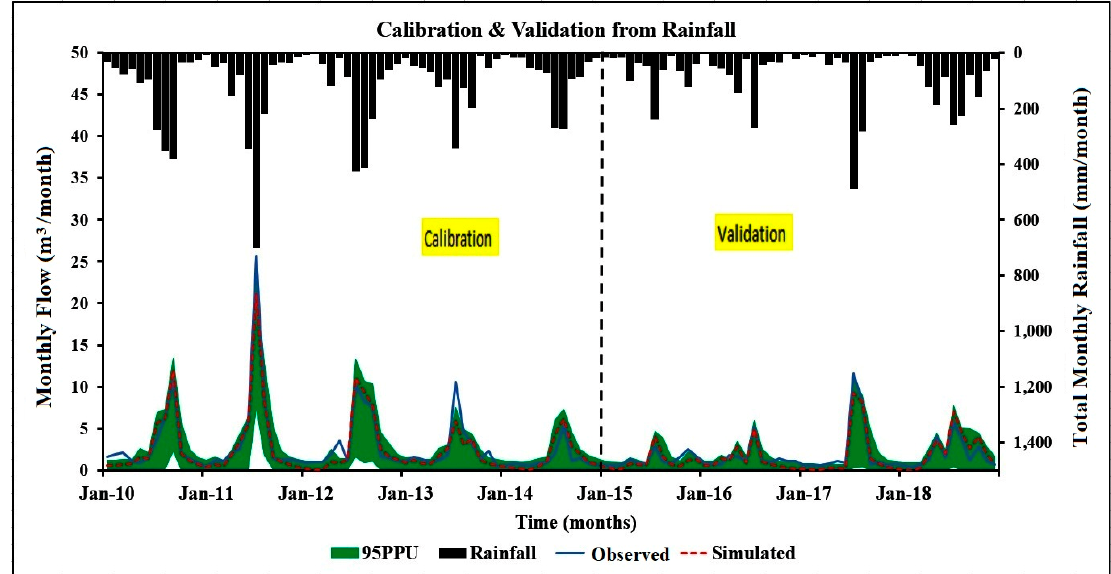
Figure 3. Model evaluation from 2010–2018 indicating the 95 percent prediction uncertainty (95PPU), rainfall, observed, and simulated data. Table 4. Model statistics for calibration and validation.